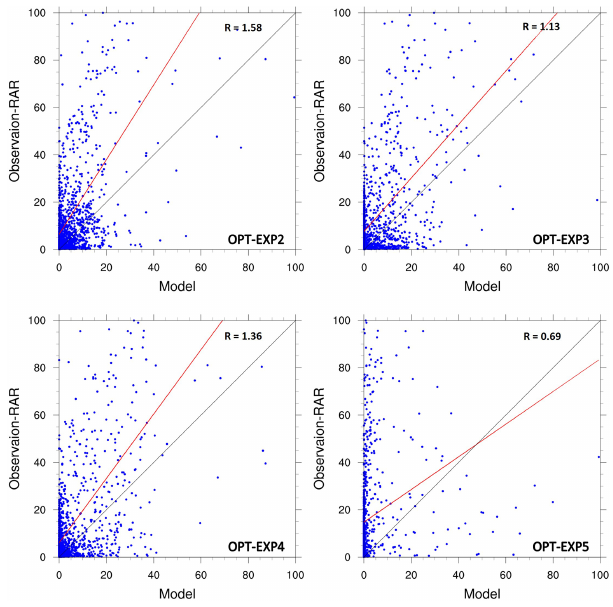
Figure 9. Scatter plot of OPT-EXP2 to